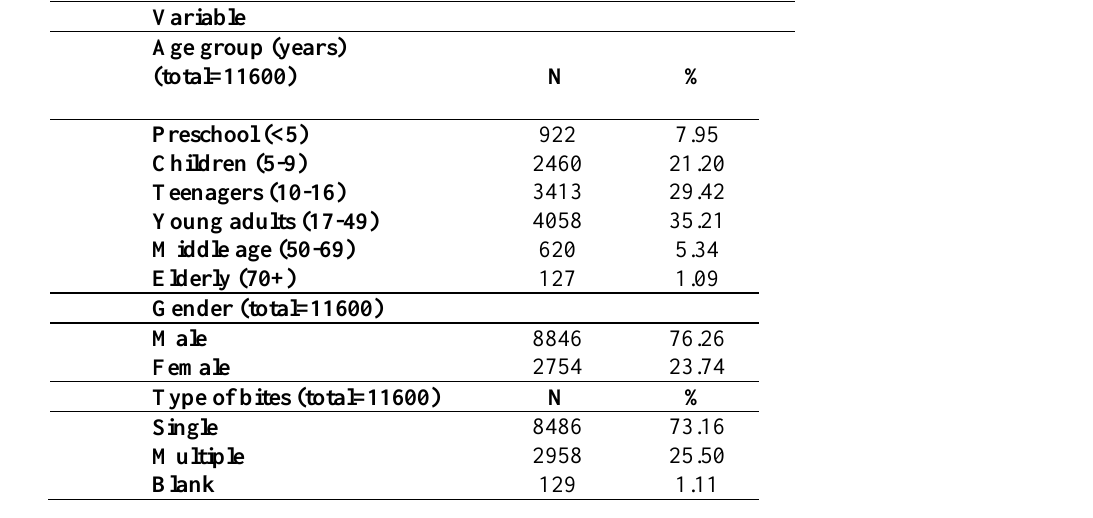
Table 1: Frequency distribution of study sample by age group, gender and type of bites